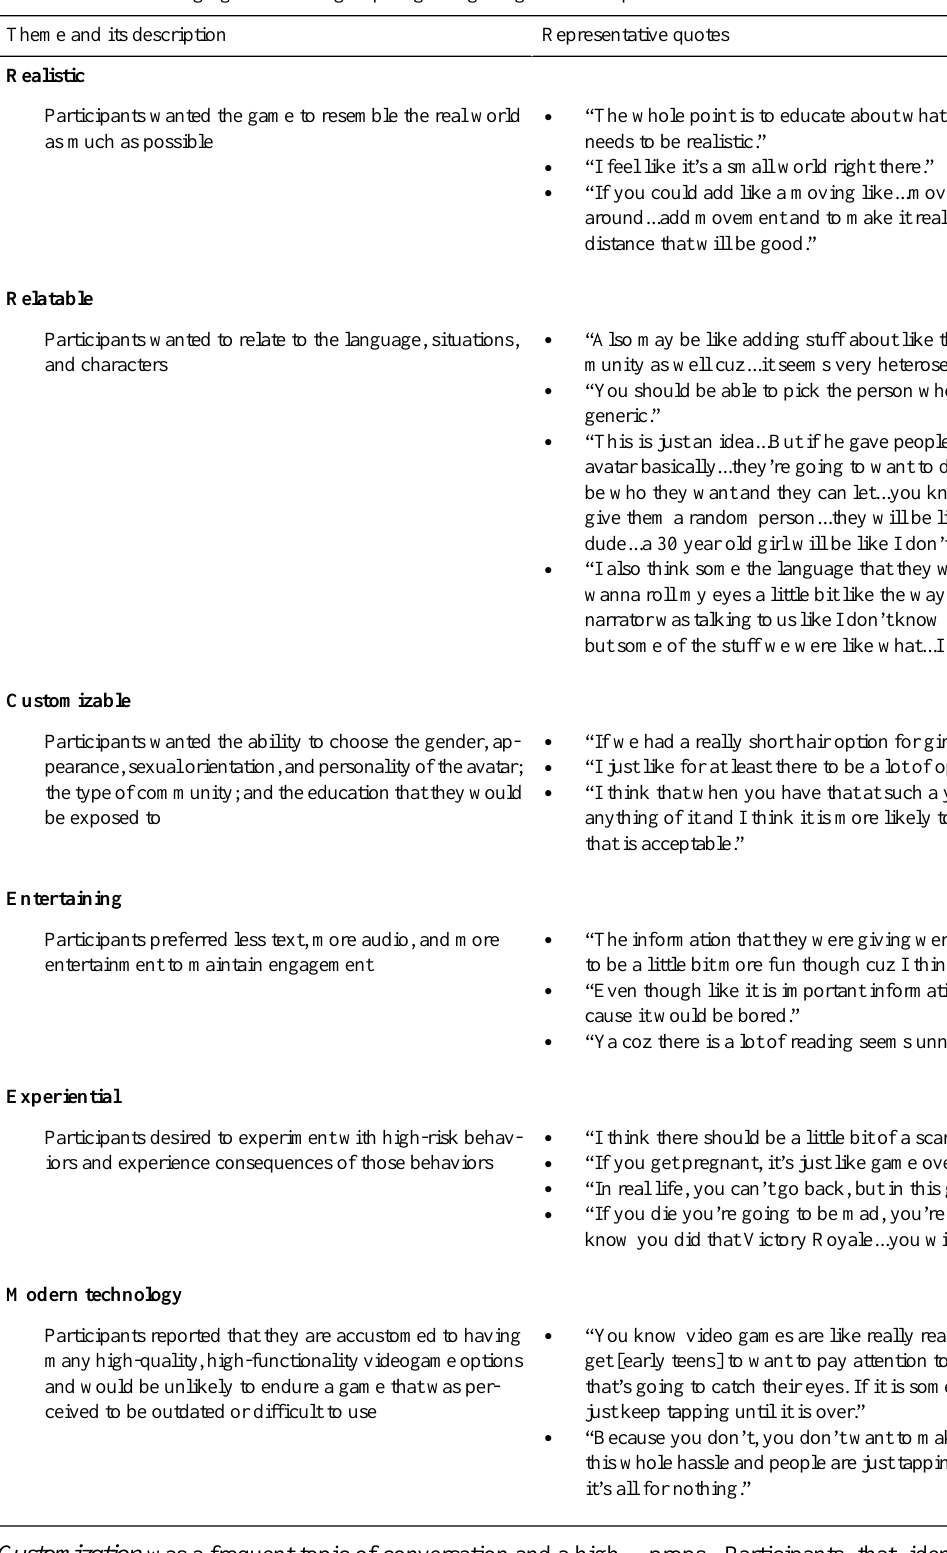
Table 3. Themes emerging from focus groups regarding the game development.